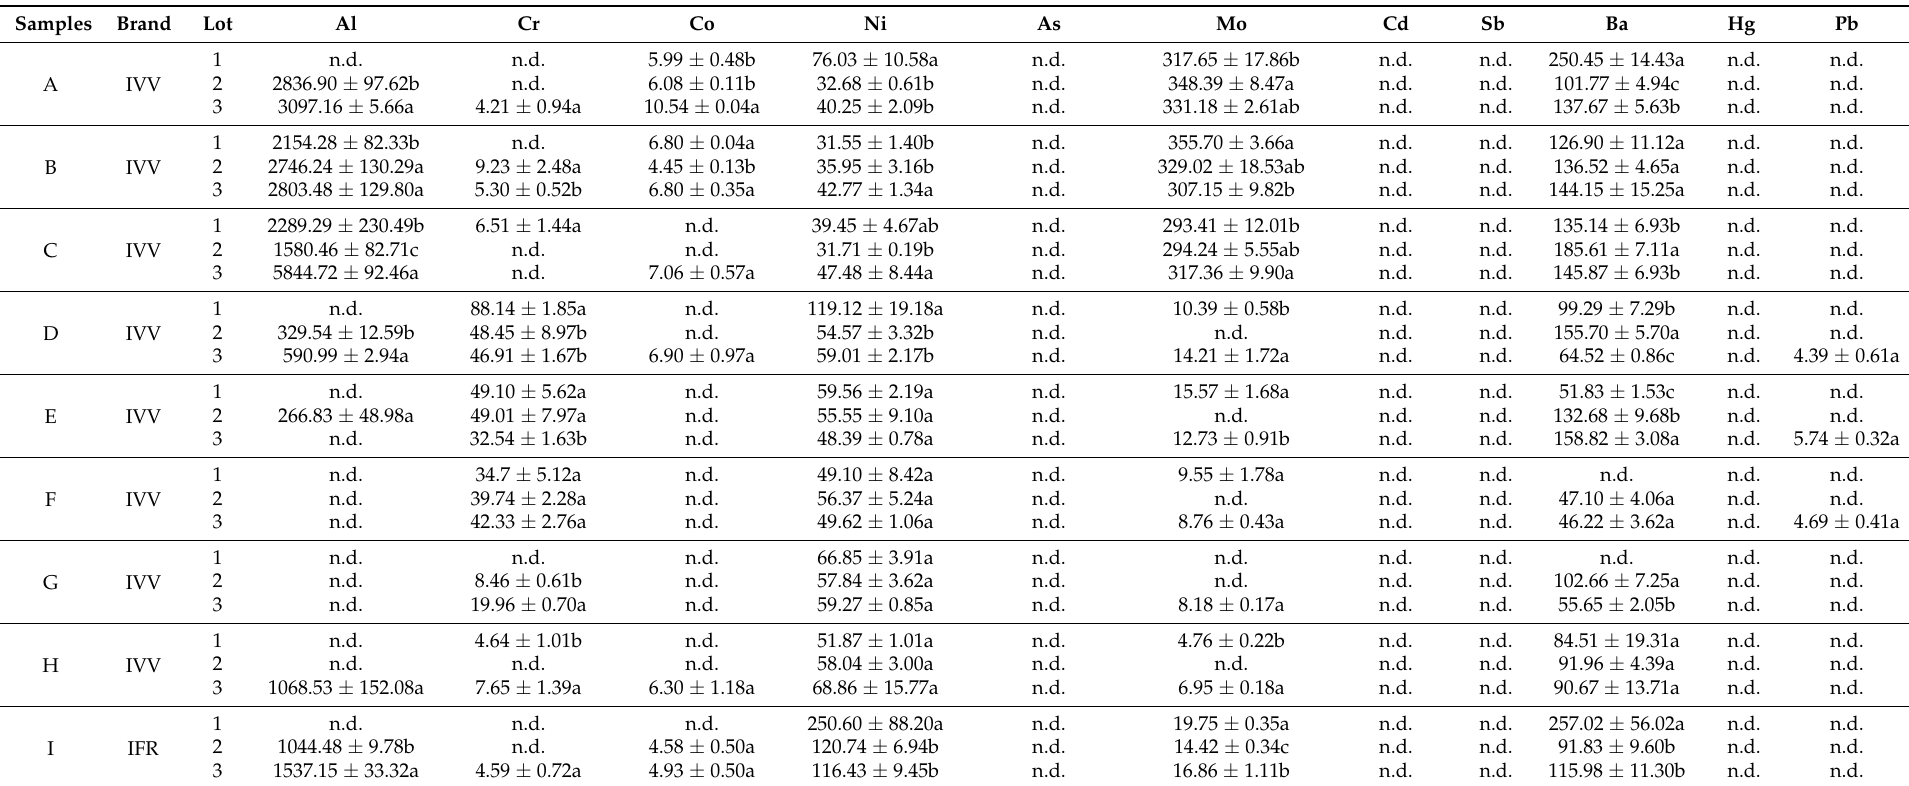
Table 3. Concentration ( µ g/kg) of 11 potentially toxic inorganic elements in yogurt samples of plant and animal origin. Samples